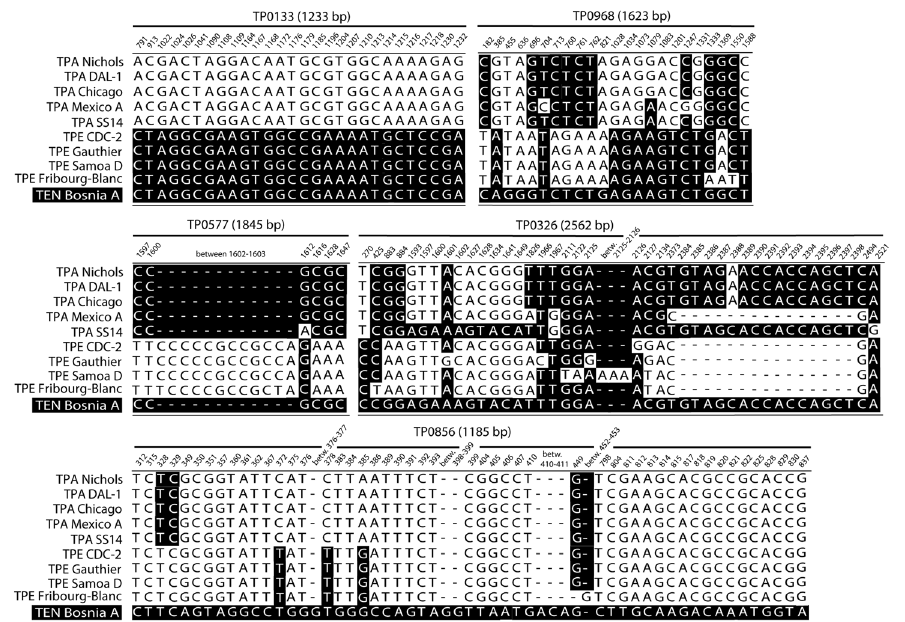
Figure 3. Sequence alignments of TENDBA_0133, TENDBA_0968, TENDBA_0577, TENDBA_0326 and TENDBA_0856 loci with the orthologous sequences of TPA and TPE genomes. Sequences of five TPA strains (Nichols, DAL-1, Chicago, Mexico A and SS14) and four TPE strains (CDC-2, Gauthier, Samoa D and Fribourg-Blanc) are shown. Numbers above the alignment represent gene coordinates in the re-sequenced TPA Nichols strain (CP004010.2 [14]). While the alignment of TENDBA_0133 showed locus completely identical to TPE strains, TENDBA_0968, TENDBA_0577 and TENDBA_0326 loci showed the presence of TPA sequences in the genome of Bosnia A. The TENDBA_0856 locus represent Bosnia A specific region with sporadic nucleotide positions identical to TPA sequences. The TPE-like sequence was found in most of the Bosnia A loci while the pattern found in TENDBA_0968 was also found in TENDBA_0858 (not shown) and the pattern identified in the TENDBA_0577 was found also in the TENDBA_1031 (not shown). The alignment pattern in TENDBA_0326 was previously found in TENDBA_0488 [12] and the pattern in TENDBA_0856 in TENDBA_0865.